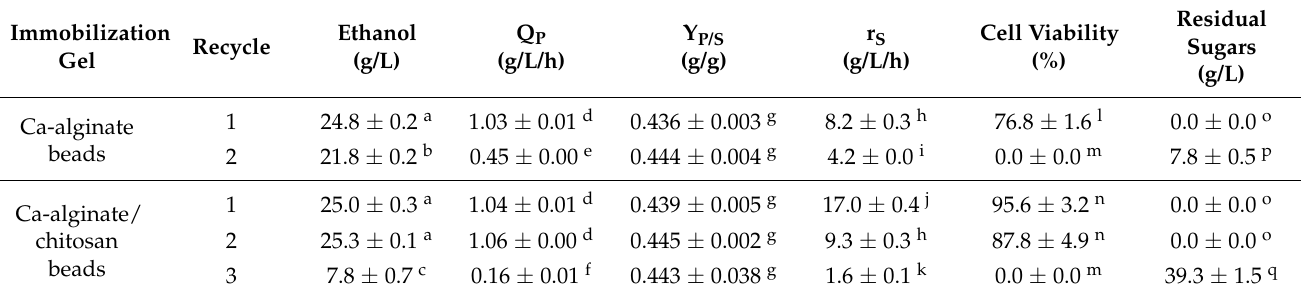
The use of the Ca-alginate/chitosan hybrid gel led to a great improvement in the process when more stressful conditions were used, such as in the experiments using YPX with 12 g/L of acetic acid and crude hemicellulose hydrolysate. In both cases, Ca- alginate/chitosan beads showed better results. However, in less toxic environments, the profiles of fermentation of the yeasts encapsulated in the two gels were similar, which suggests that chitosan complements the protective layer for yeasts provided by alginate, producing a synergistic effect. Scanning electron microscopy (SEM) of the beads shows that the presence of chitosan in the hybrid gel really seems to grant greater structural stability to the beads (Figure